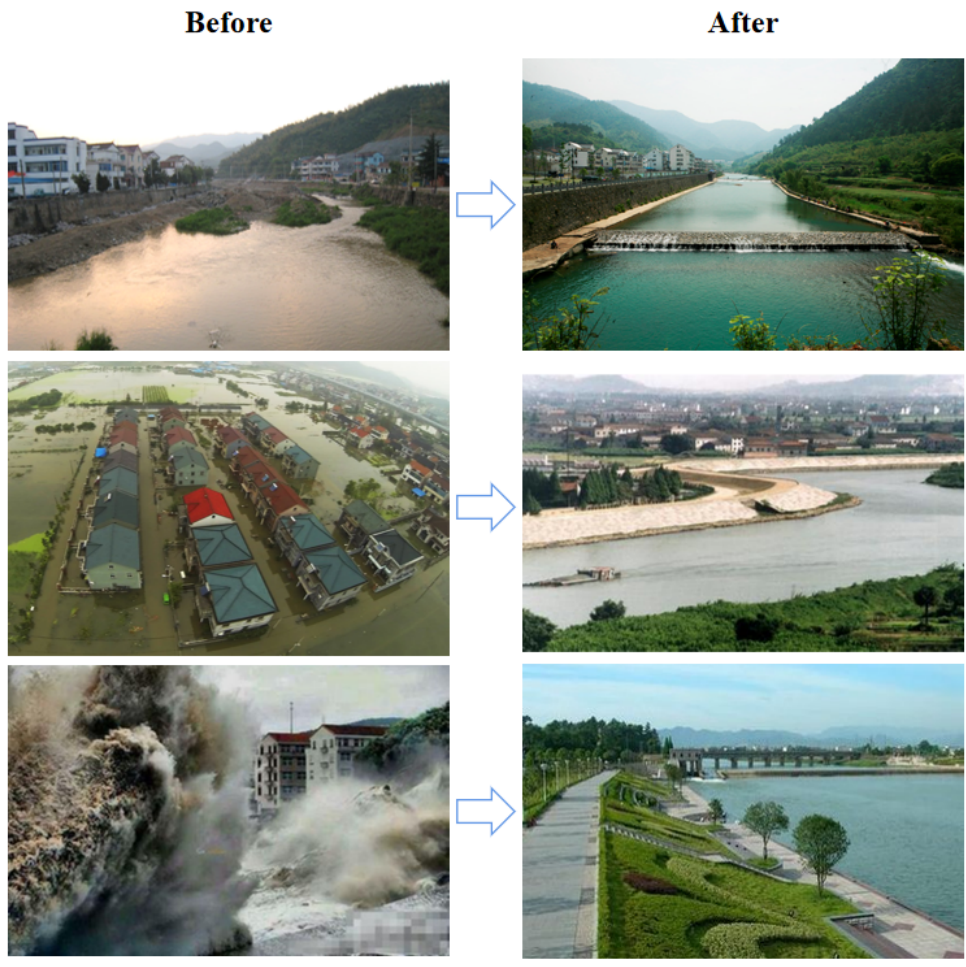
Figure 7. The effectiveness of Virtuous